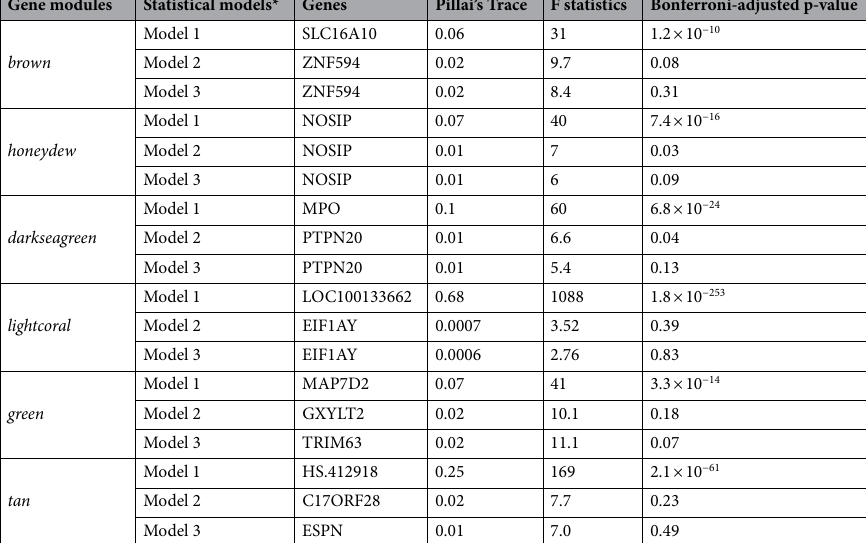
Table 4. Multivariate analysis of variance (MANOVA) test results from association analyses between member genes of the six significant gene modules and early traits of both osteoporosis and atherosclerosis using three differently adjusted models (1–3), as described in the table footnote*. The topmost ranking genes based on the Bonferroni-adjusted p-value for each of the three models are presented. Statistical models*: MANOVA model 1 was designed to investigate joint association between the summary expression profile of the gene modules and early traits of both osteoporosis and atherosclerosis with no covariates. Model 2 was adjusted with age, sex and body mass index. Model 3 was thesame as model 2 but additionally adjusted for smoking, alcohol consumption and variables related to physical